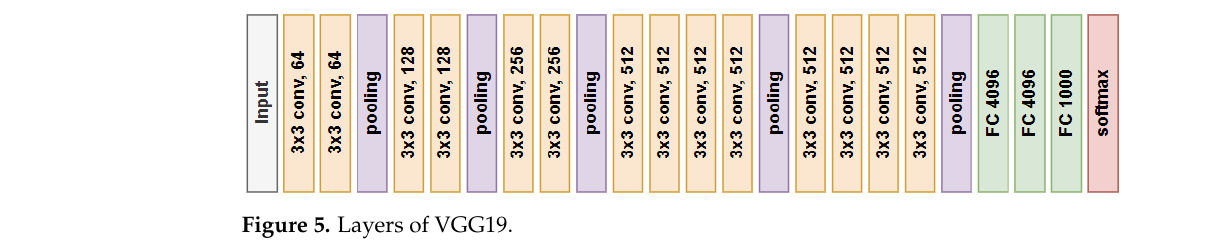
Figure 4. VGG19 model architecture.